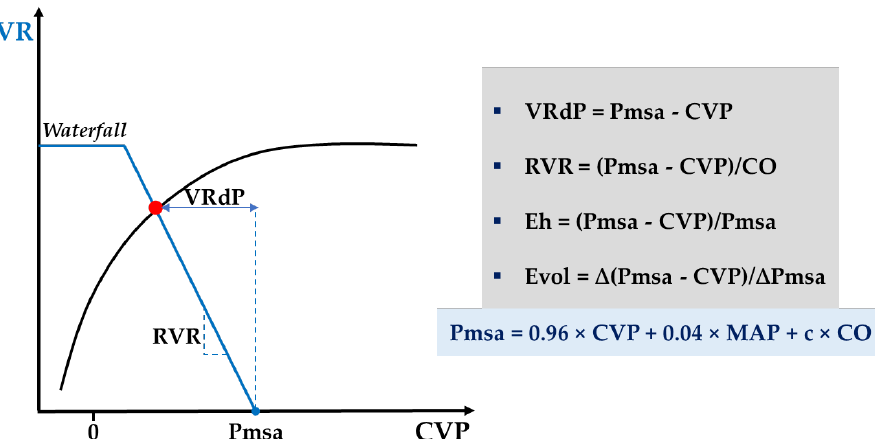
Figure 5. A schematic illustration of the steady-state interaction (red dot) between venous return (blue curve) and cardiac function (black curve) introducing Parkin’s Guytonian perspective on global heart efficiency. c, anthropometric constant; CO, cardiac output; CVP, central venous pressure; Eh, global heart efficiency; Evol, volume efficiency; MAP, mean arterial pressure; Pmsa, mean systemic filling pressure analogue; RVR, resistance to venous return; VR, venous return; VRdP, pressure gradient for venous return; ∆, change after a preload challenge. See Appendix A, Table A1 for further discussion.